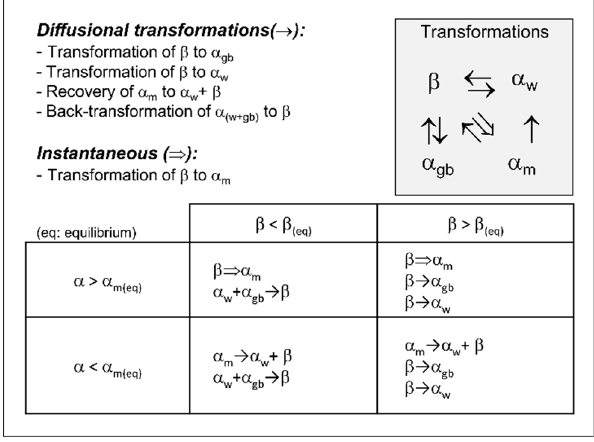
Figure 4. Transformation process and constituent interactions.